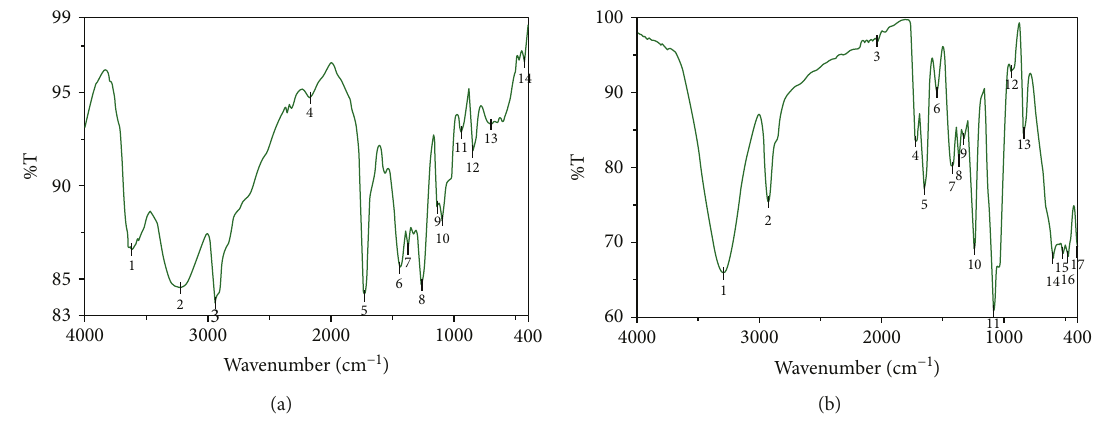
Figure 4: FTIR spectra of the prepared hydrogels: (a) HG; (b) HGE. Table 2: Main FTIR spectral assignments in the prepared hydrogels. Wave number Hydrogel (cm -1 )